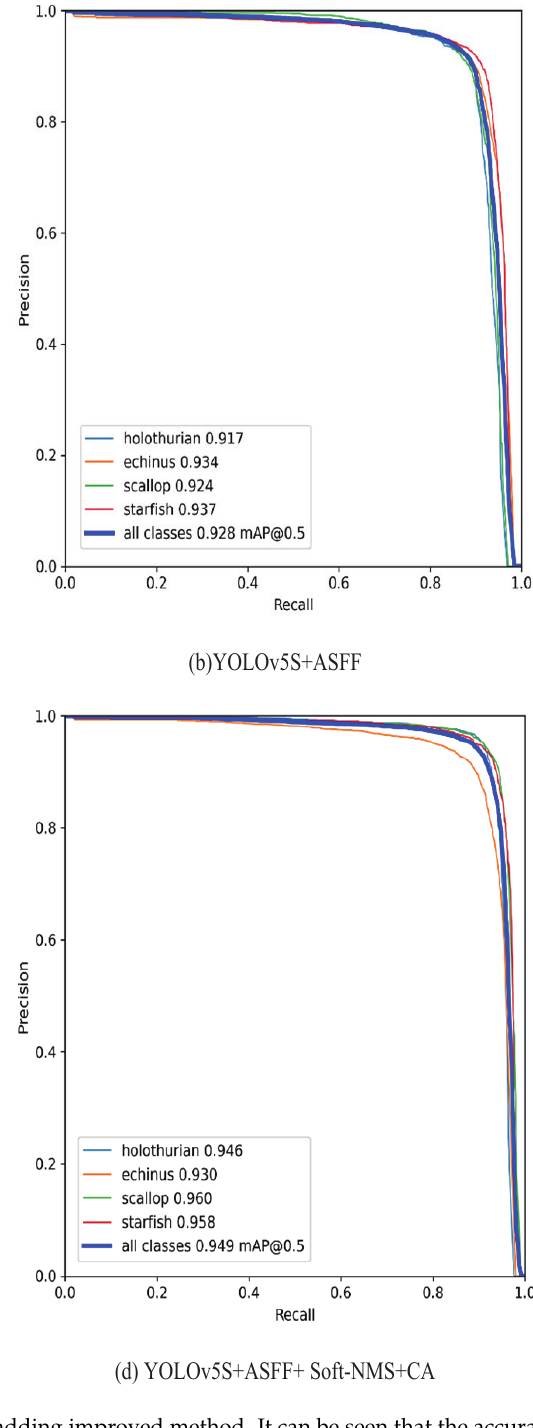
Figure 8. Test P-R diagram of successively adding improved method. It can be seen that the accuracy of the model increases with the addition of improved